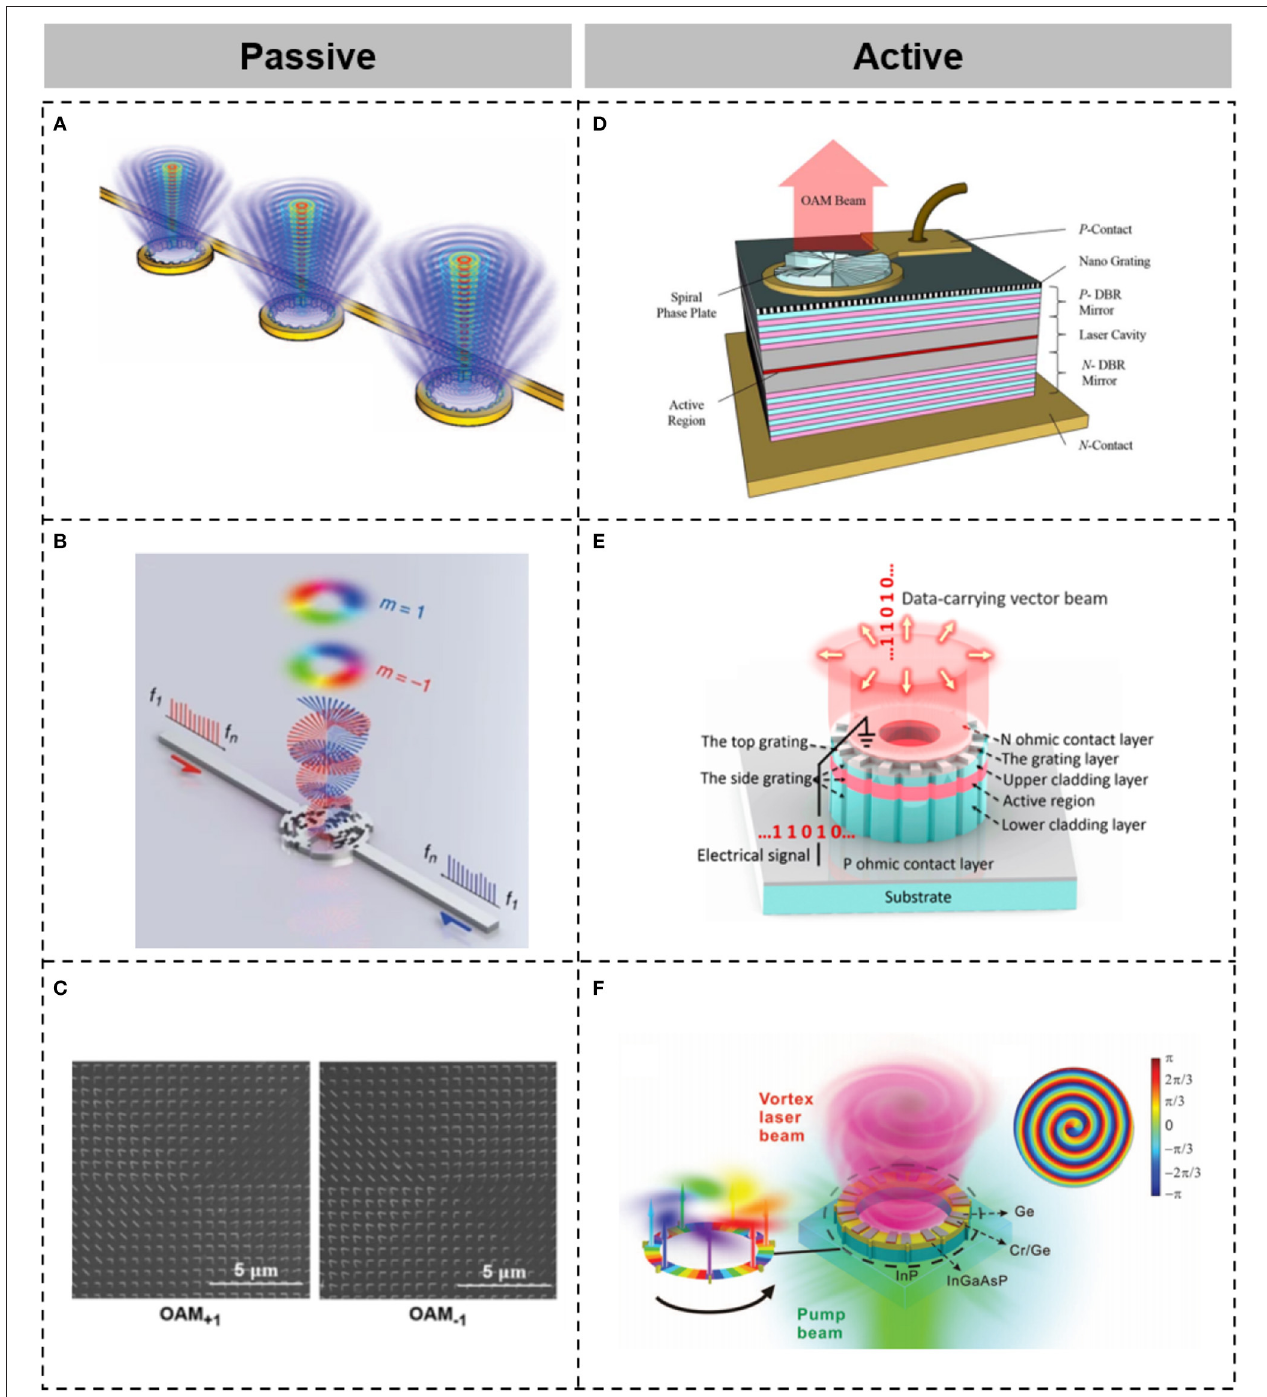
FIGURE 5 | Generation of spatial-structured light beams, utilizing integrated devices. (A) Schematic of an optical vortex emitter based on silicon microring with angular gratings. Reprinted from Cai et al. [55]. (B) Schematic of a broadband optical vortex emitter. Reprinted from Xie et al. [58]. (C) Schematic of reflection-enhanced plasmonic metasurface for generating a phase helix and an intensity helix. Reprinted from Zhao et al. [64]. (D) Schematic of a vertical-cavity surface-emitting laser with an integrated spiral phase plate at the output port. Reprinted from Li et al. [68]. (E) Schematic of a high-speed directly modulated cylindrical vector beam laser. Reprinted from Ma et al. [70]. (F) Schematic of an optical vortex microlaser on an InGaAsP/InP platform. Reprinted from Miao et al. [69].